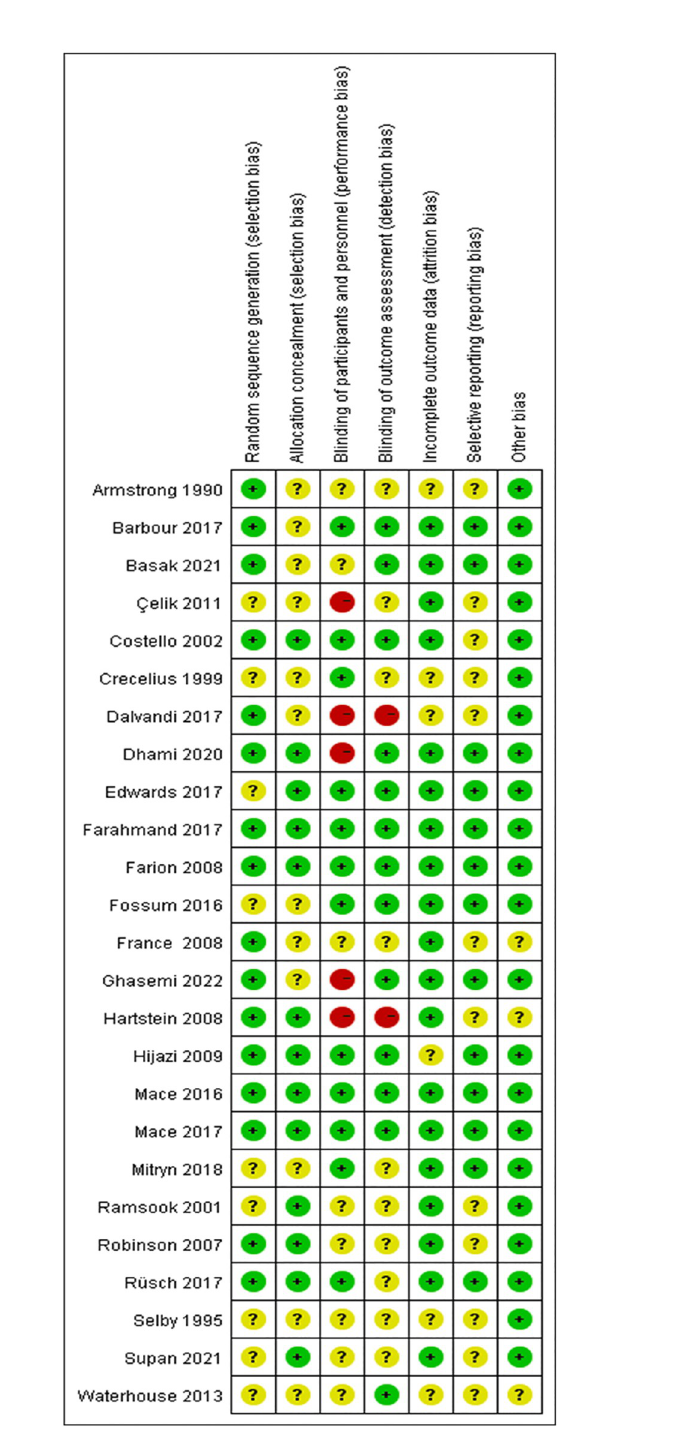
Fig 2. Summary of risk of